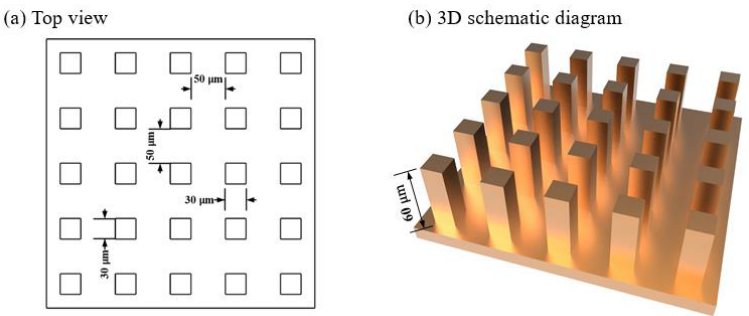
Figure 1. The main dimensional parameters of surface microstructure: ( a ) top view; ( b ) 3D schematic diagram .